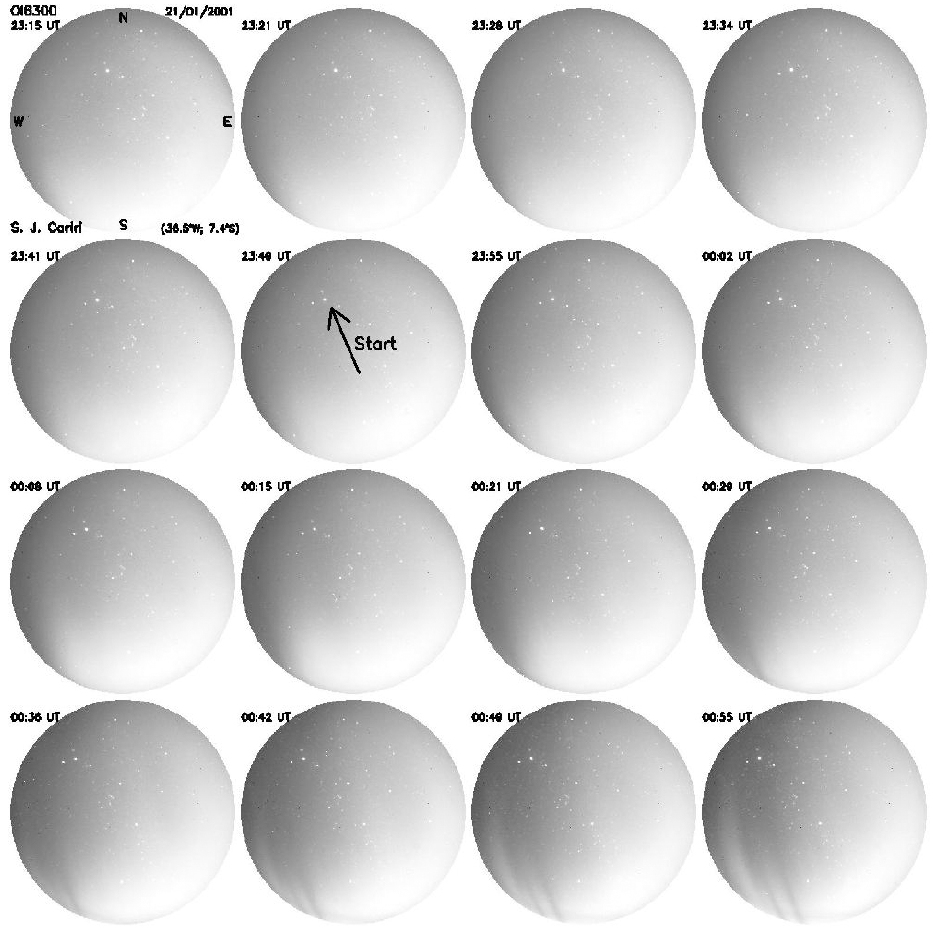
Figure 1. Sequence of OI6300 airglow images observed in São João do Cariri on 27 January 2001. One can observe the start time of the EPB on this night (see also Paulino,